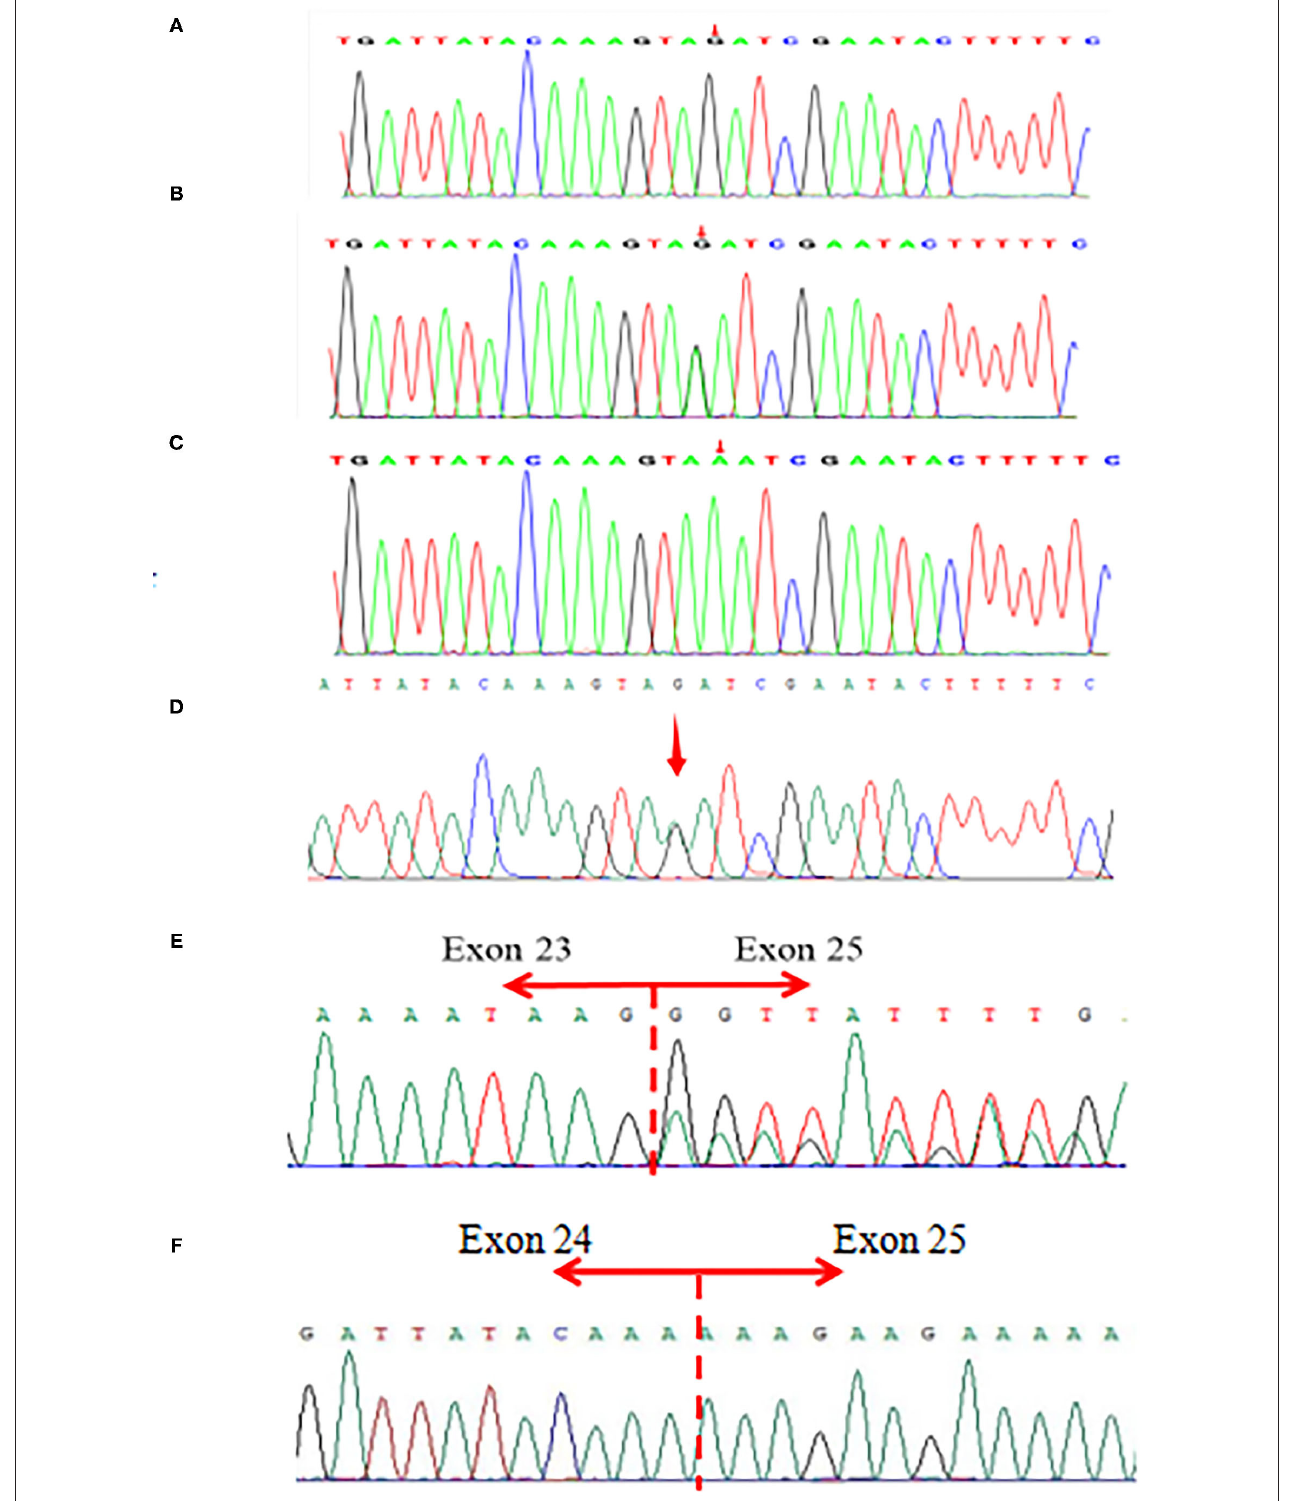
FIGURE 1 | (A–D) Sanger sequencing of the patient and parents. (A) A hemizygous ATRX gene variant (c.5786 + 4A > G; NM_000489.6) in the patient. (B,D) A heterozygous ATRX gene variant (c.5786 + 4A > G) in the proband’s mother and maternal grandmother. (C) Not found in his father. (E,F) The results of RT-PCR revealed that a proportion of the transcripts of ATRX from the patient lost entire exon 24, and the mother’s was totally normal.